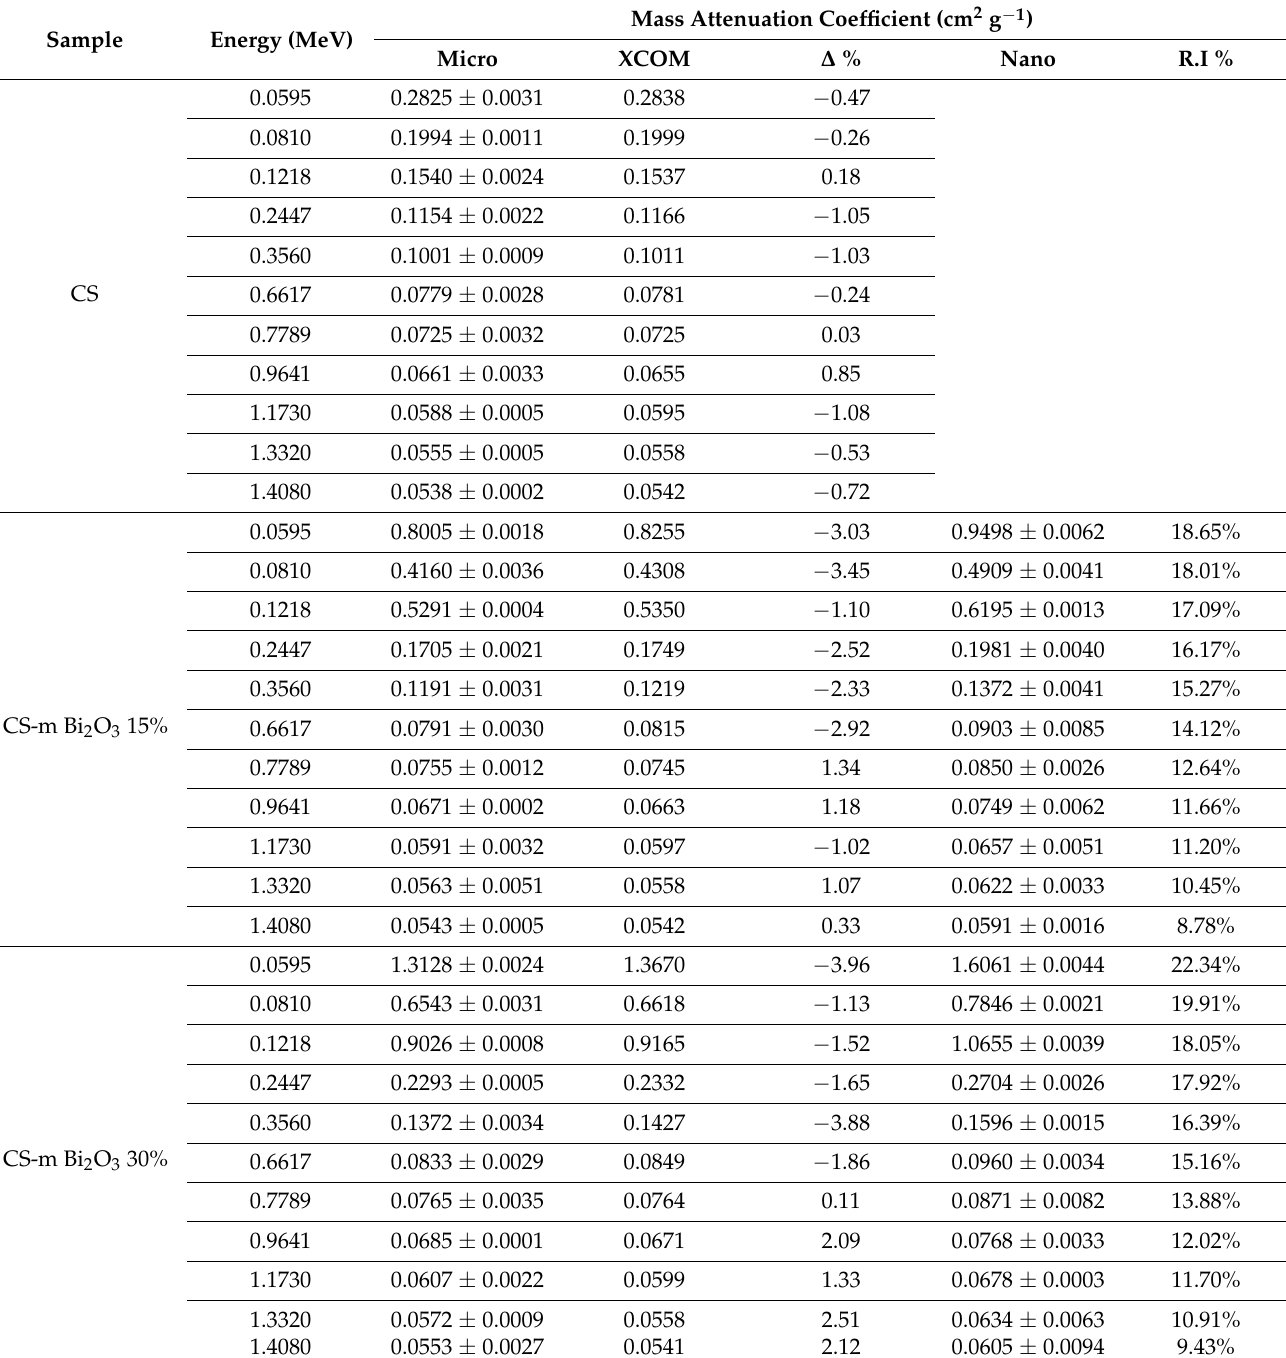
Table 4. Experimental and theoretical values of MAC of all samples at different photon